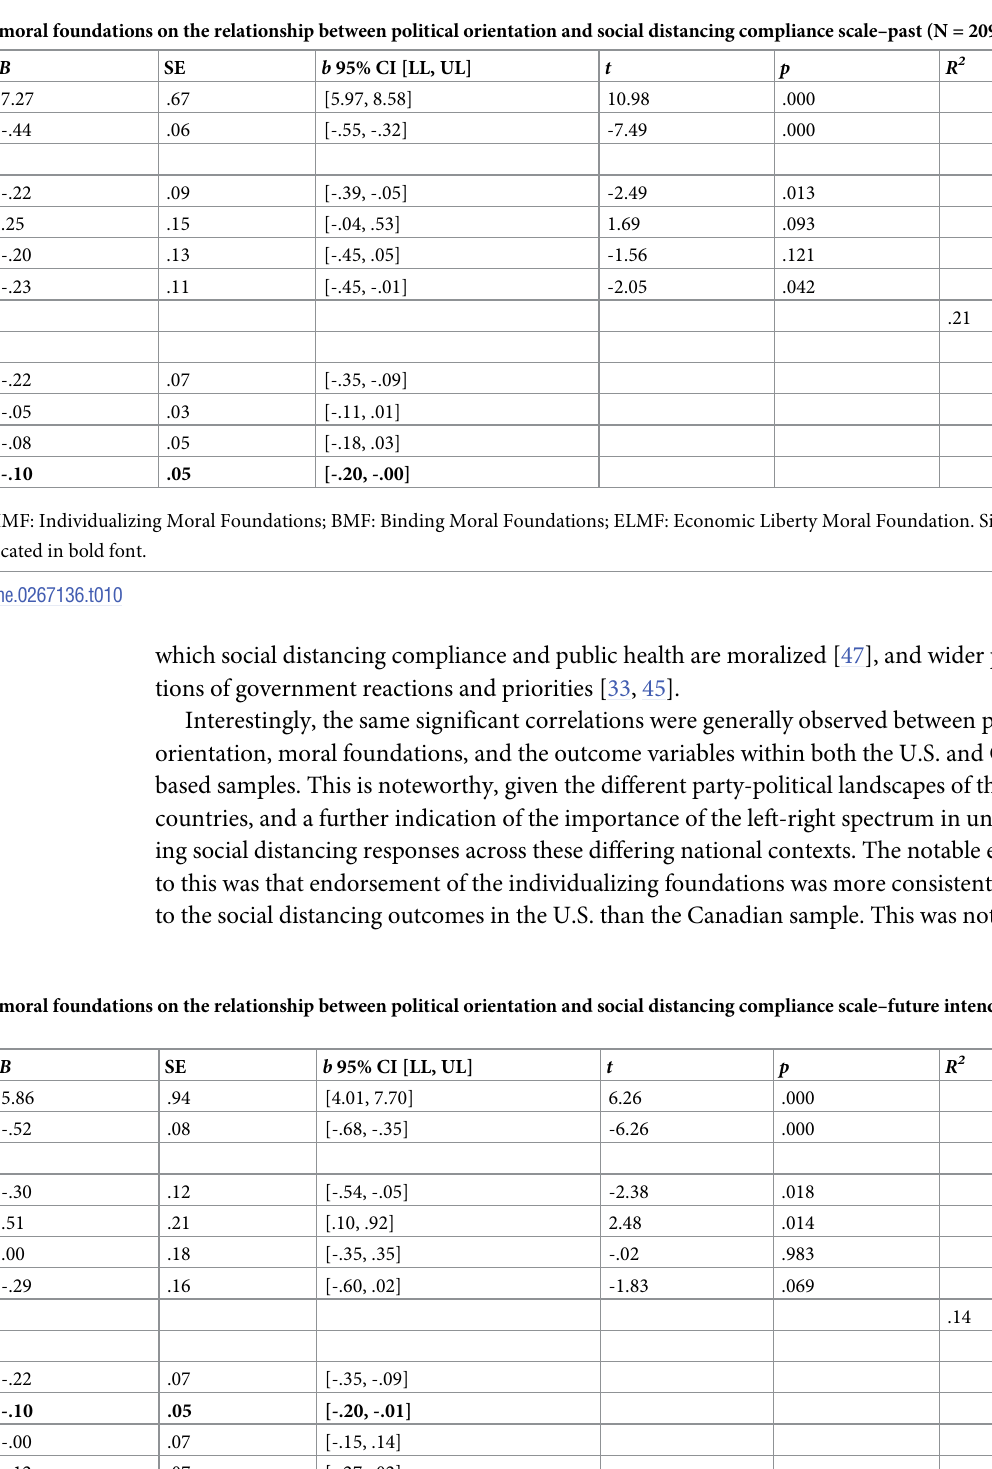
Table 10. Mediation effects of moral foundations on the relationship between political orientation and social distancing compliance scale–past (N = 209). Predictor